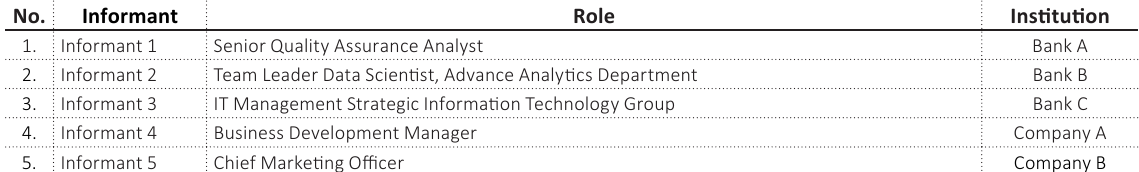
Table 1. List of informants No.